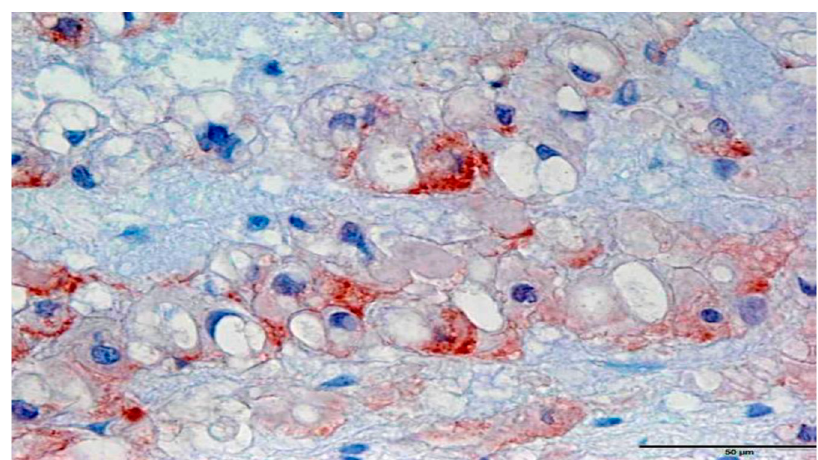
Figure 2. Immunohistochemical staining of Gli1 expression in a cranial chordoma. The expression strength of the cytoplasmic granular staining of the tumor cells corresponds to the score 3 (magnification 400 ×).